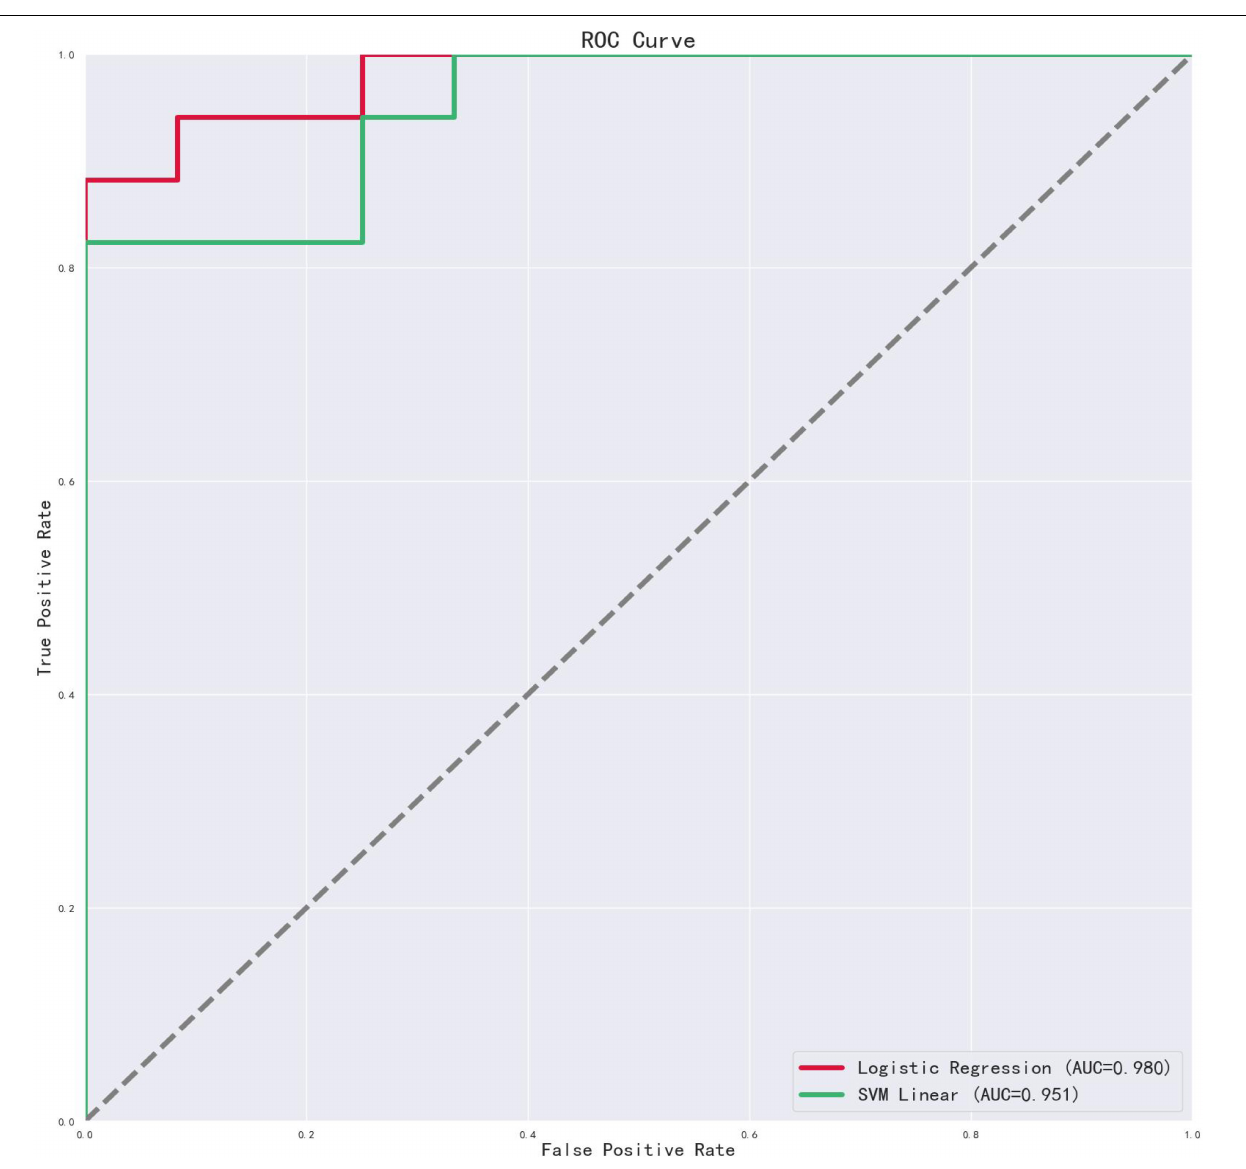
FIGURE 1 | ROC curves of acoustic features in LR and SVM models. The red line represents LR model; the green line represents SVM model; the horizontal axis is the false positive rate, and the vertical axis is the true positive